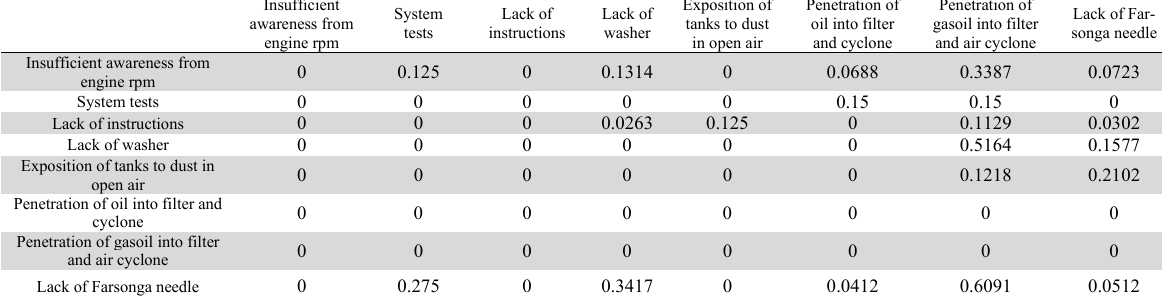
Insufficient awareness from